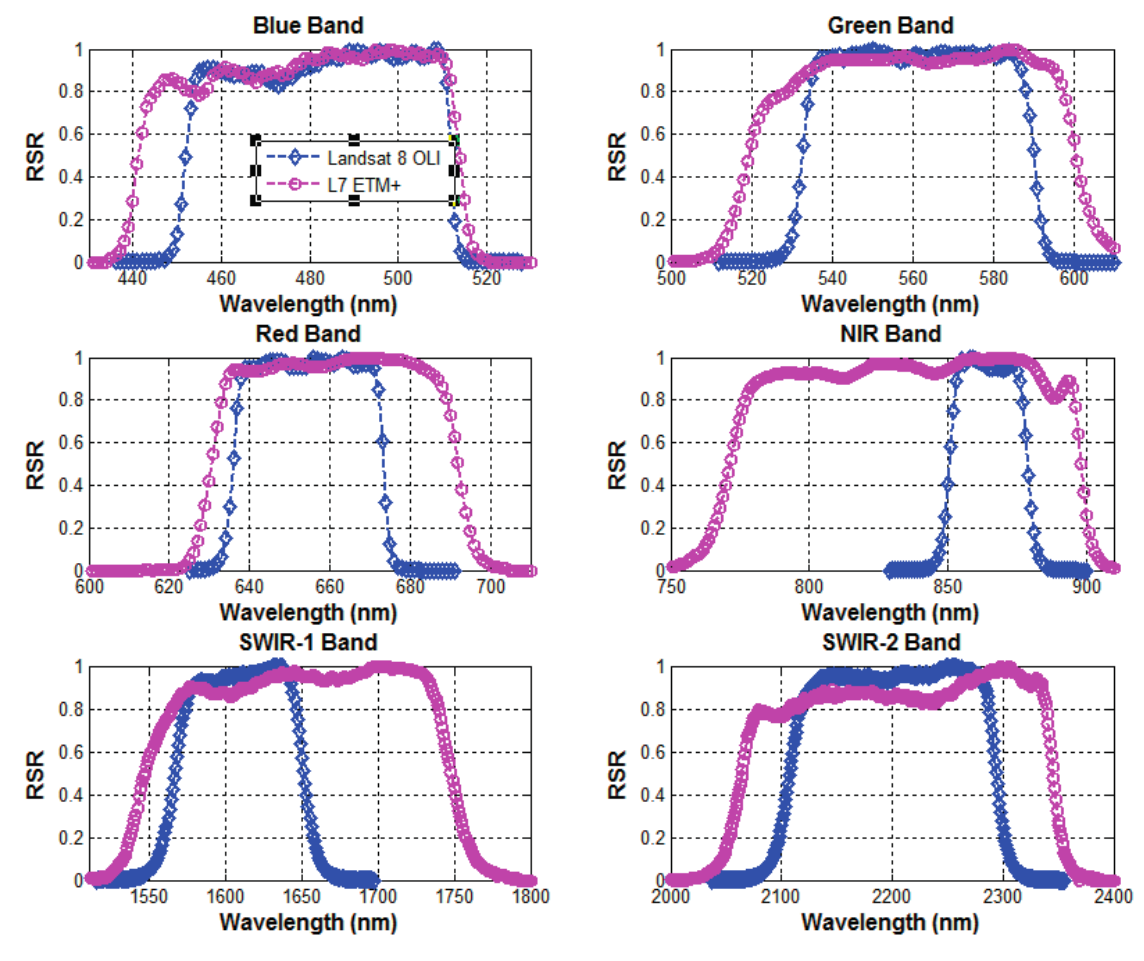
Figure 2. Relative Spectral Response (RSR) of L8 OLI and L7